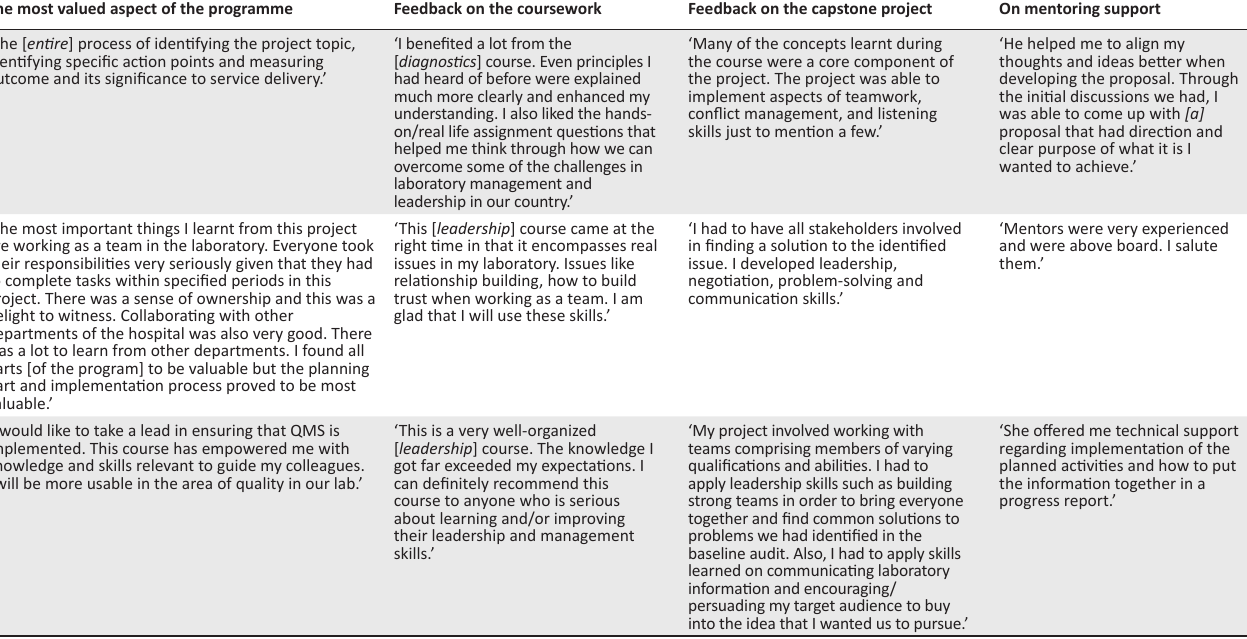
TABLE 4: Qualitative feedback from participants about the programme, Zambia, 2016–2018. The most valued aspect of the programme